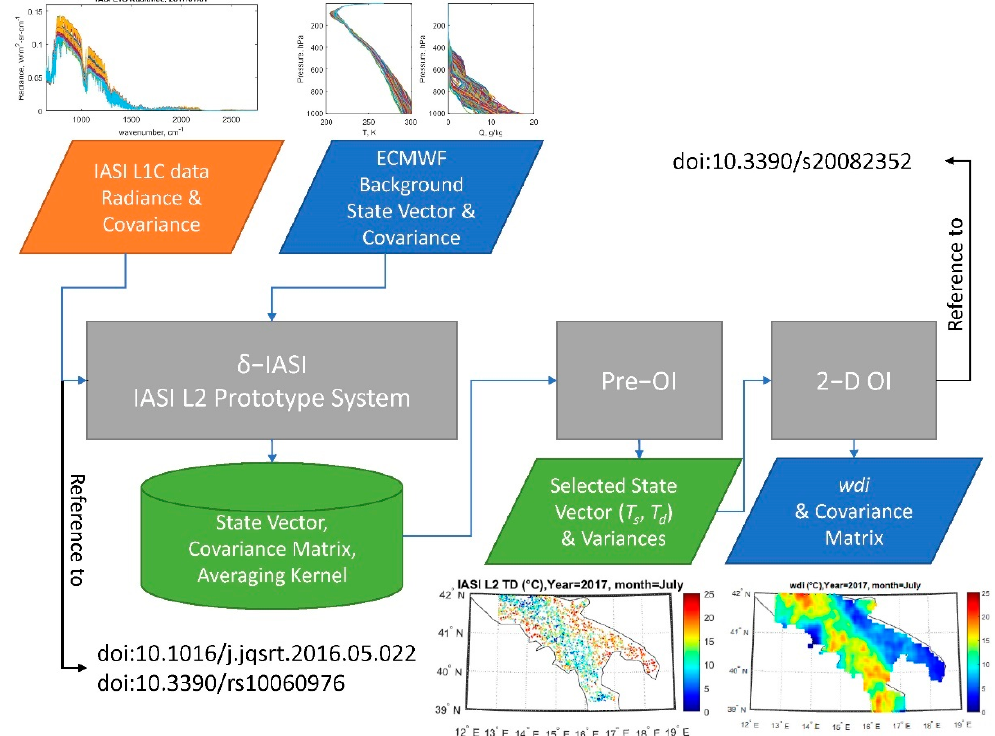
Figure 2. Schematic flow chart of the methodology developed in the present study to yield Level 3 monthly maps of the water deficit index [30,33,34]. monthly maps of the water deficit index